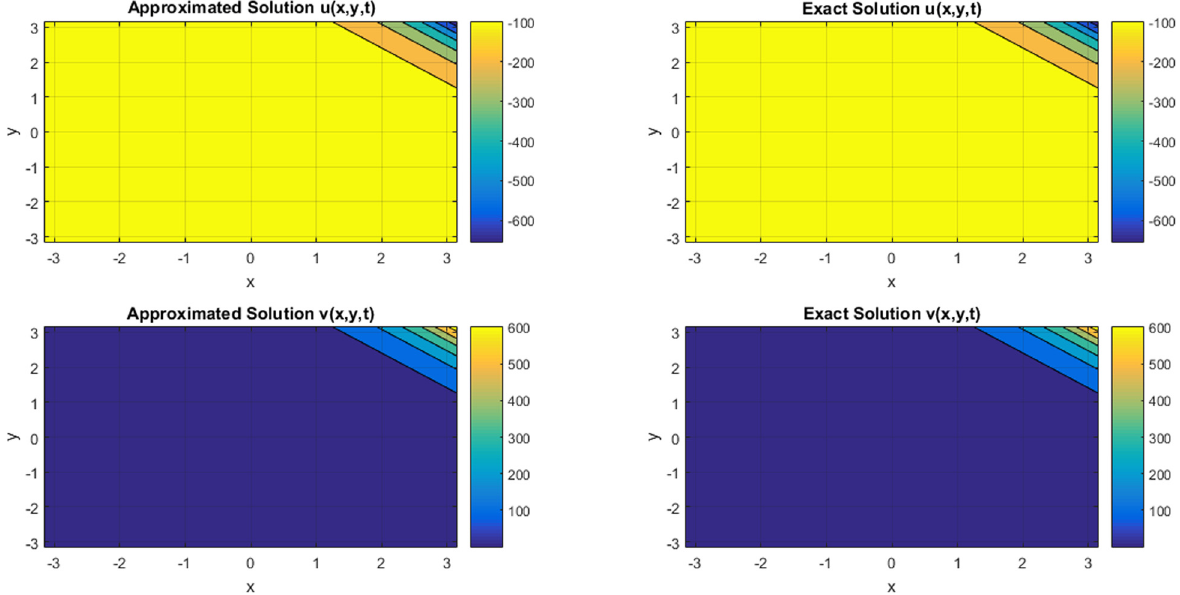
Figure 8: Contour plot for comparison of approximated and exact solutions at t = 1 with ρ = 0.1 and N = 11 for ϕ and ψ components regarding Example